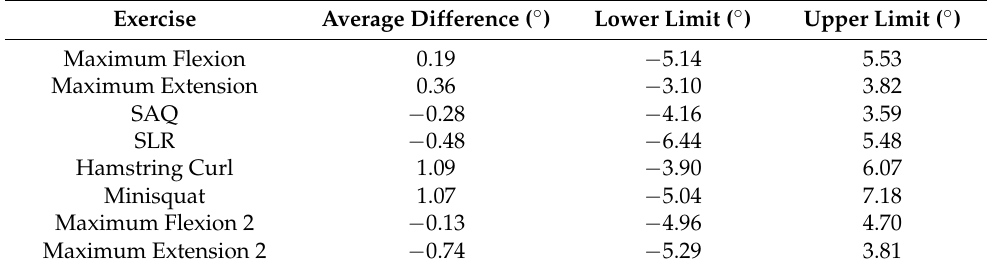
Figure 4. Bland–Altman plots for the range of motion of each exercise for 5 repetitions. Table 1. Average difference between knee brace and OptiTrack systems for each exercise from Bland–Altman plot.